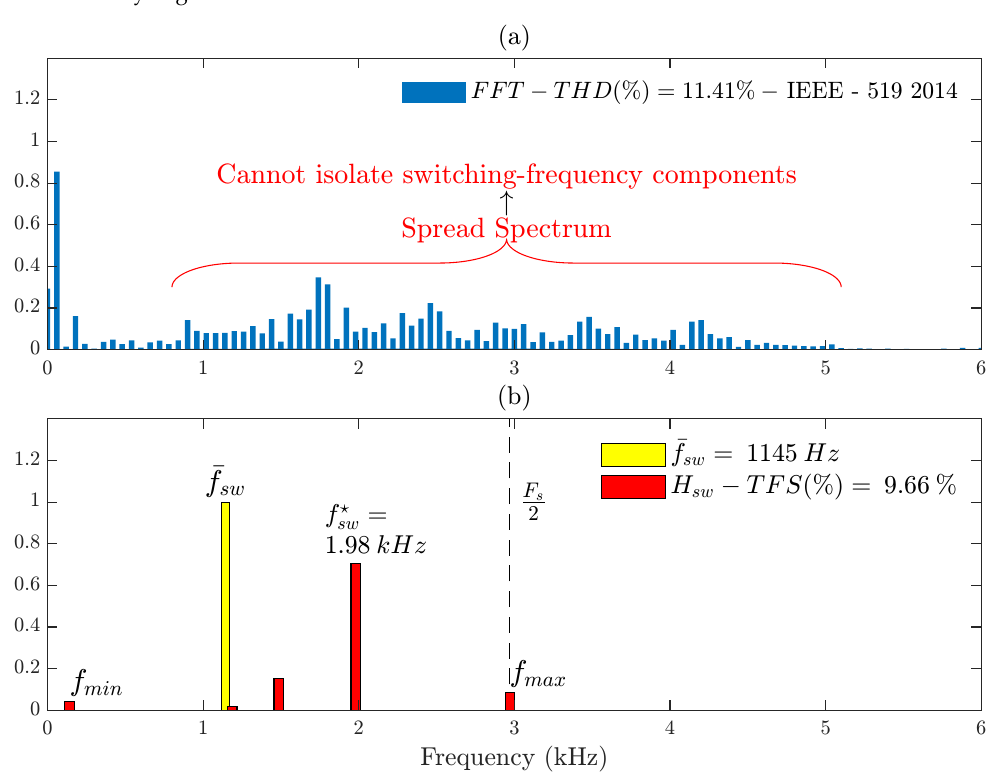
Figure 6. FCS-MPC-based converter with sampling frequency equal to 5940 Hz ( F s = 99 × 60 Hz): ( a ) FFT of the switching pulses and ( b ) switching frequency components ( H sw ) obtained by Algorithm